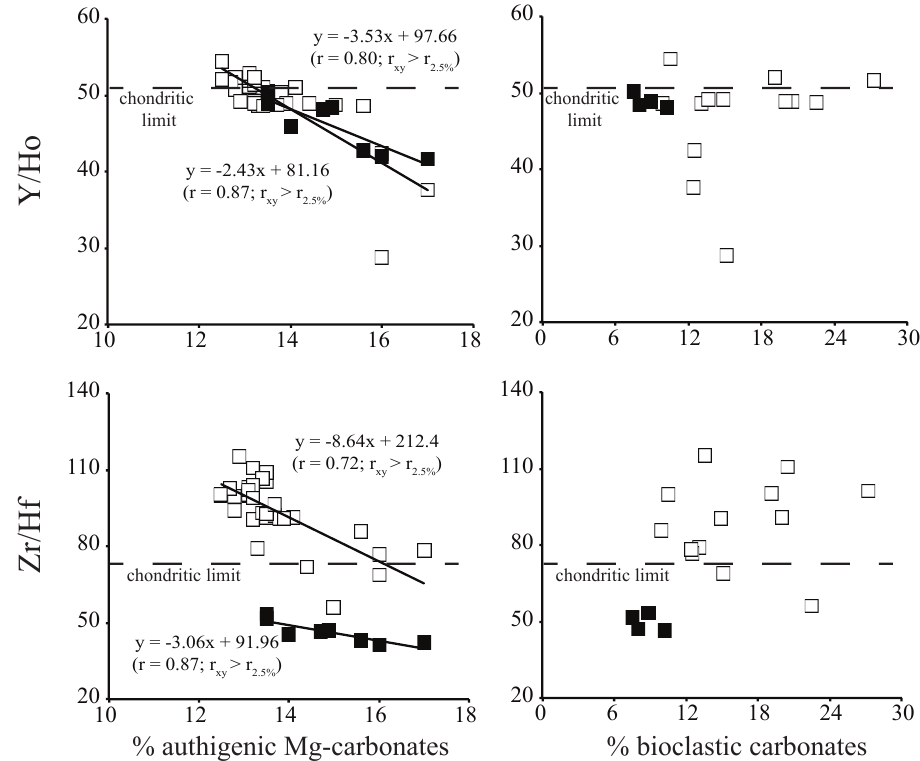
Fig. 5. Relationships between Y/Ho and Zr/,Hf molar values and contents (weight %) of authigenic Mg-rich (dolomite and magnesium calcite) and bioclastic carbonates. Symbols as in Fig. 4. Chondritic values are reported for comparison. Figure 5 – Relationships between Y/Ho and Zr/Hf molar values and contents (weight %) of 627 authigenic Mg-rich (dolomite and Mg-calcite) and bioclastic carbonates. Symbols as in Fig. 4. 628 the external cellular walls from the surrounding environment Chondritic values are reported for comparison. 629 (Merroun et al., 1998). Both microbial assemblages and